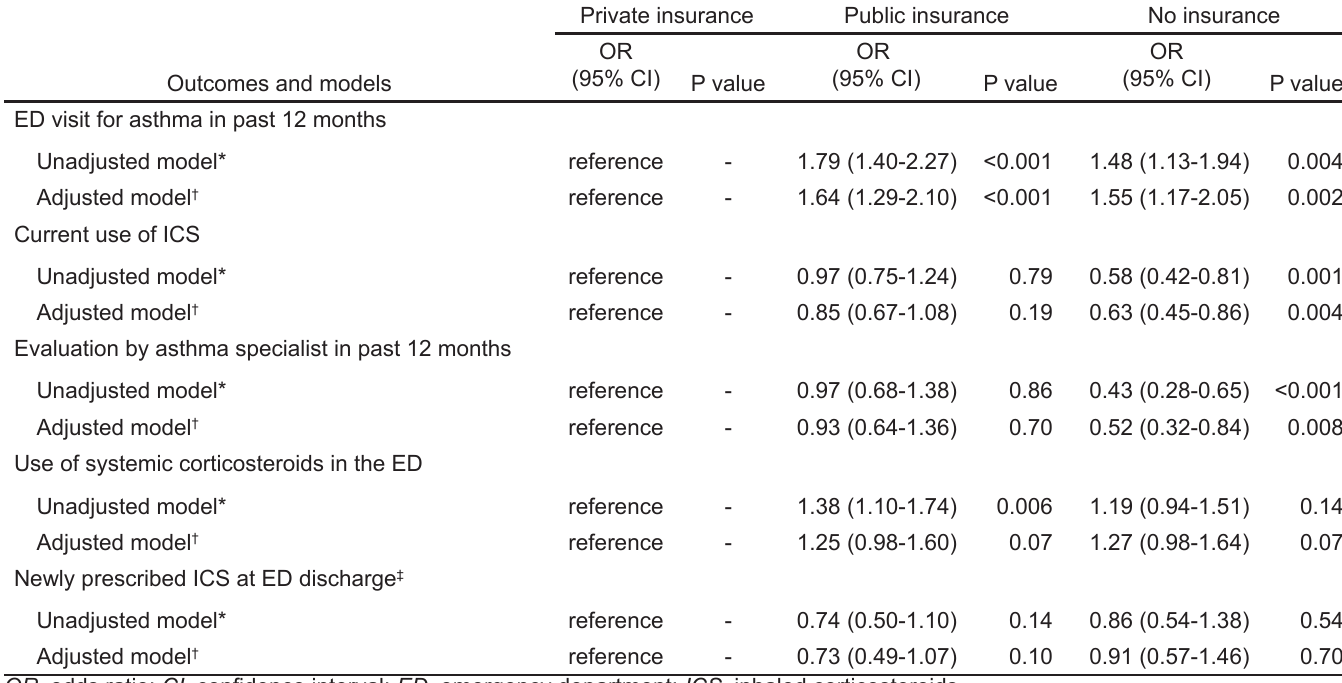
OR, odds ratio; CI, confidence interval; ED, emergency department; ICS, inhaled corticosteroids *Unadjusted logistic regression model using the generalized estimating equations to account for patient clustering within EDs. † Multivariable logistic regression model using the generalized estimating equations to account for patient clustering within EDs, with adjusting for age, sex, race/ethnicity, estimated household income, and history of hospitalization and intubation for asthma exacerbation. ‡ Analyzed for discharged patients who did not report recent use of inhaled corticosteroids